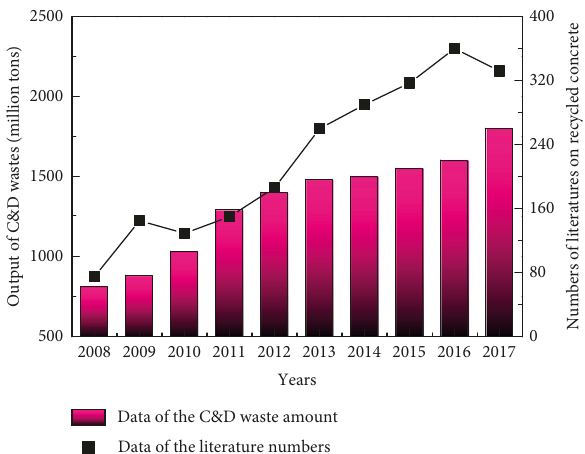
Figure 1: Output of C&D waste and the related literatures in China over the past